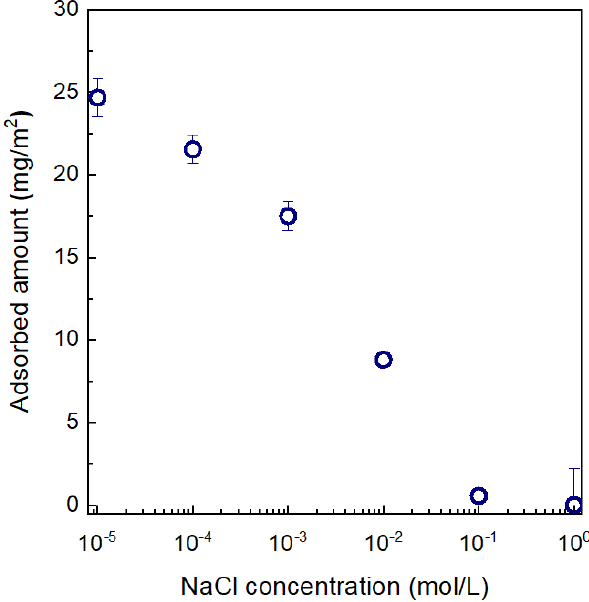
Figure 6. The dependence of the adsorbed amount of CPVA (DC = 1.36 mol%) on NaCl concentra- tion, C s . The plot at C s = 10 − 5 mol/L is the result for no salt addition (the conductivity is less than 1 µS/cm), which was regarded as C s = 0 mol/L. Error bars indicate standard deviations. 1 µ S/cm), which was regarded as C s = 0 mol/L. Error bars indicate standard